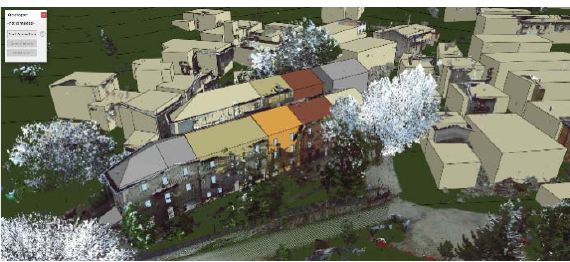
Figure 11. Detail of the buildings with point clouds